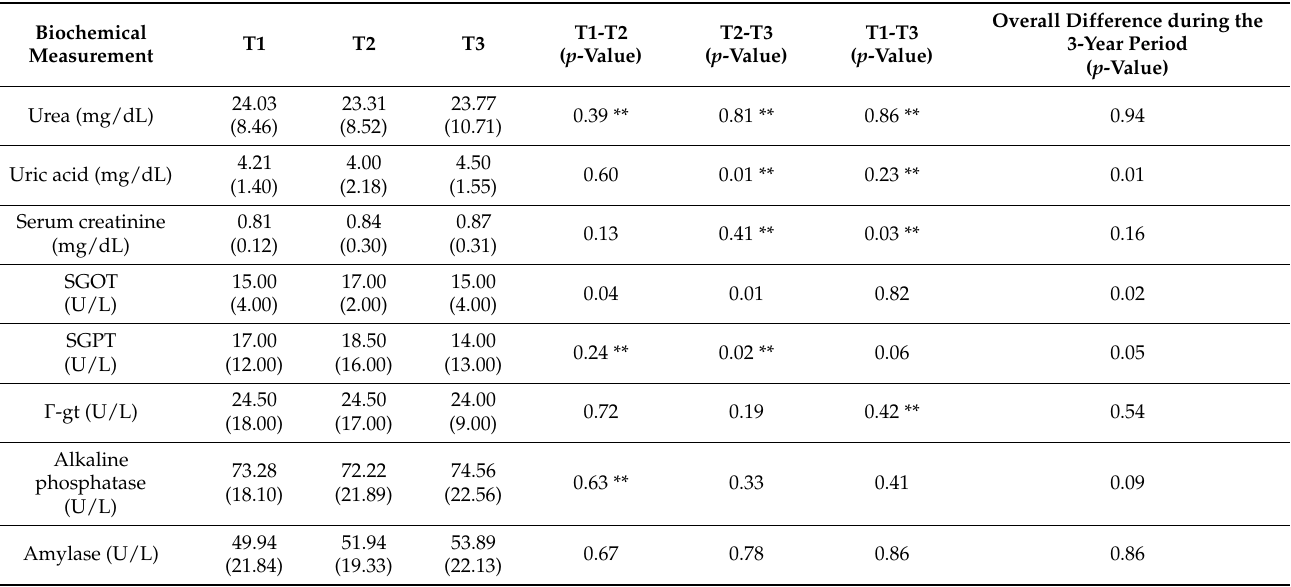
Table 3. Changes (difference tests) in the biochemical measurements of forensic psychiatric patients taking second-generation antipsychotics with a higher risk of weight gain (AP2) over the three-year study period (time points T1, T2, T3) (N =